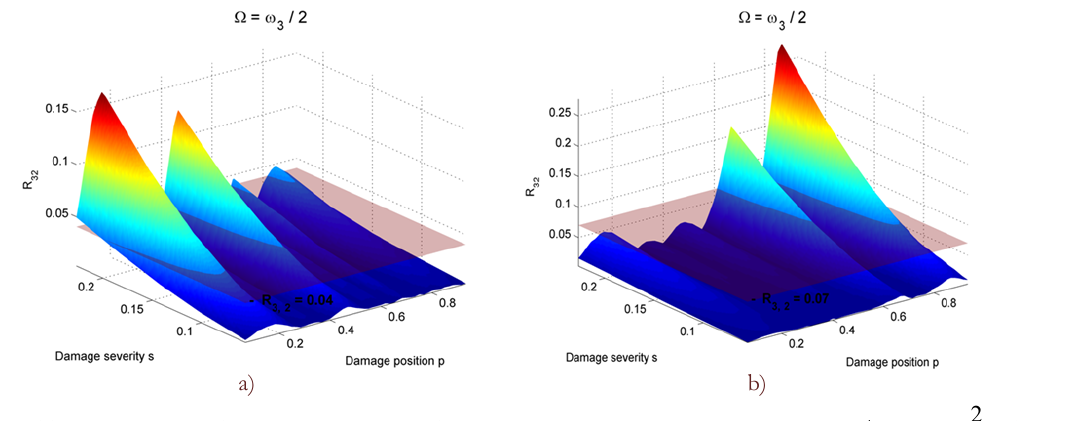
Figure 3: Spanned beam: Harmonic damage surfaces R 32 order 2 super-harmonic component for Ω =